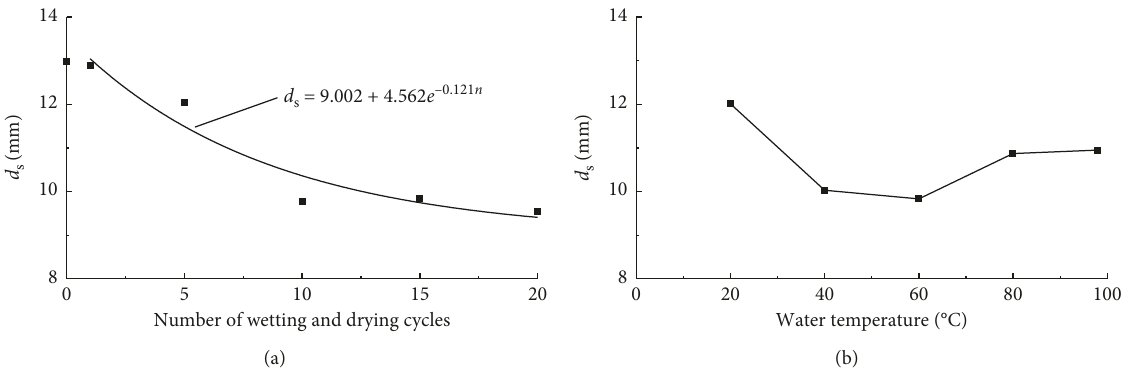
Figure 10: Average fragment size variation after cyclic wetting and drying treatment. (a) Average fragment size versus the number of wetting and drying cycles. (b) Average fragment size versus water